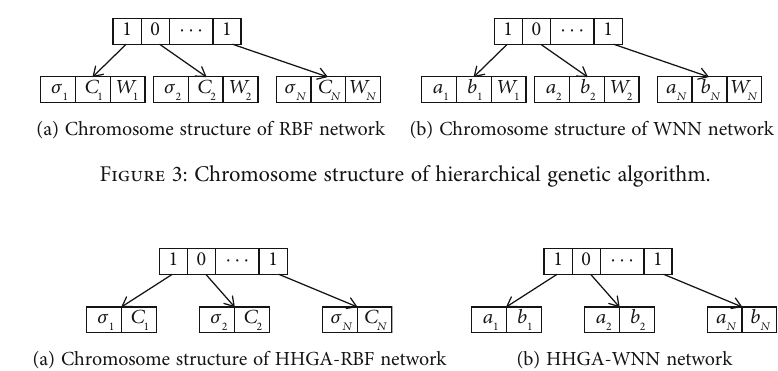
Figure 4: The parameters related to the hidden layer neurons are retained in the hierarchical